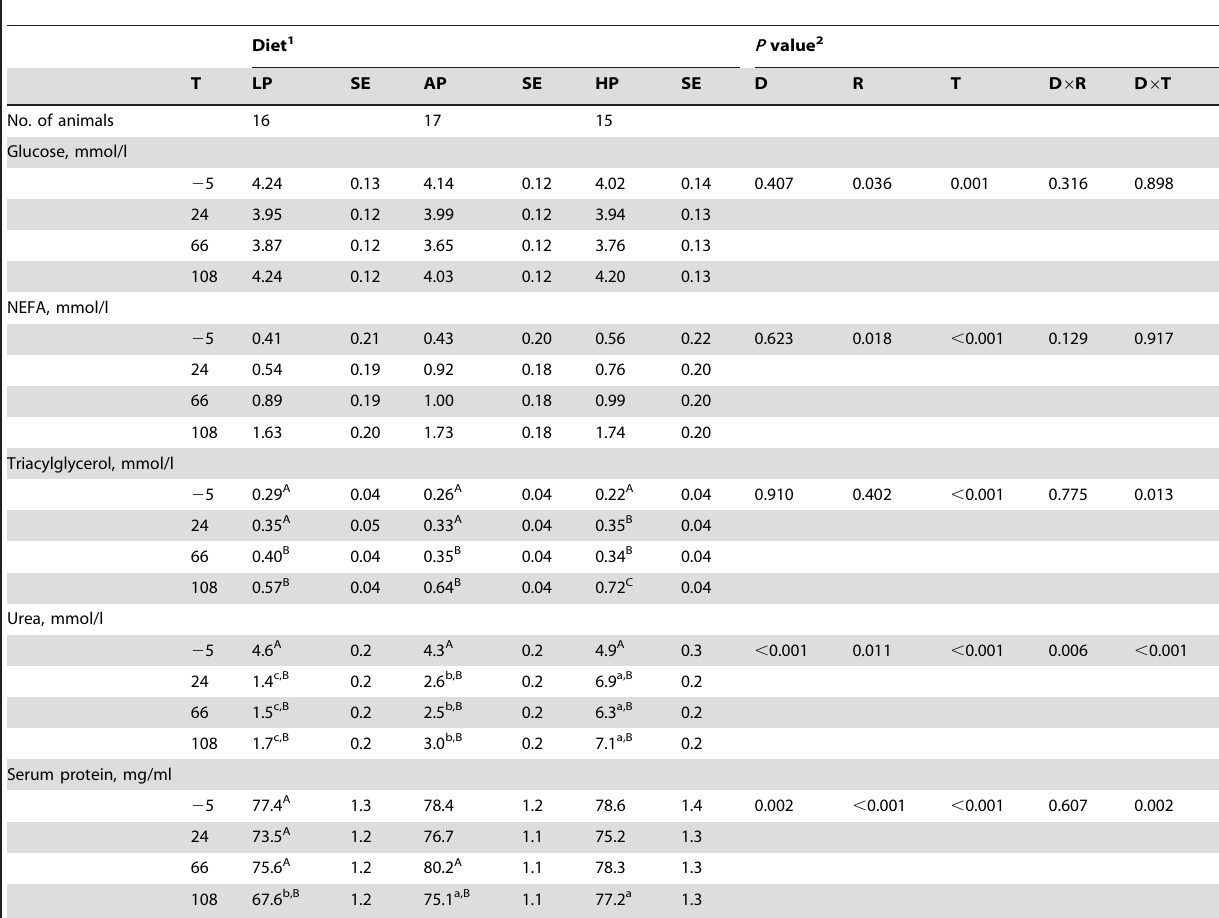
Table 3. Basal plasma metabolite concentrations of sows at 5 days before and 24, 66 and 108 days after insemination.